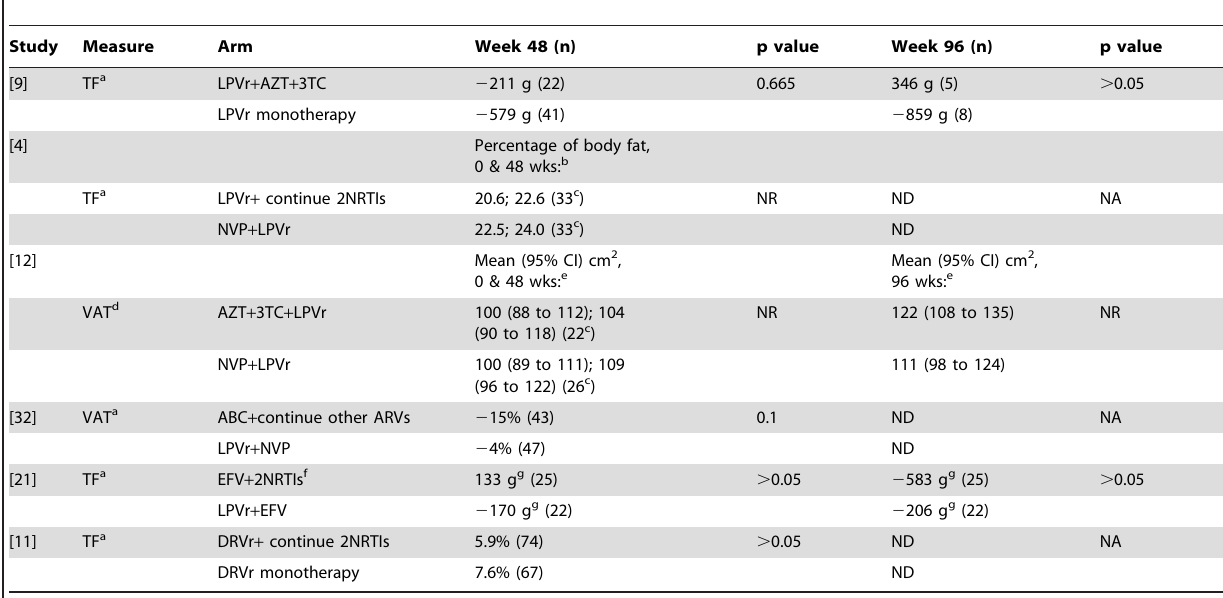
Table 12. Change from baseline in trunk fat (TF) on DEXA scan, and visceral adipose tissue (VAT) on CT scan: NRTI-containing regimens versus NRTI-sparing regimens.